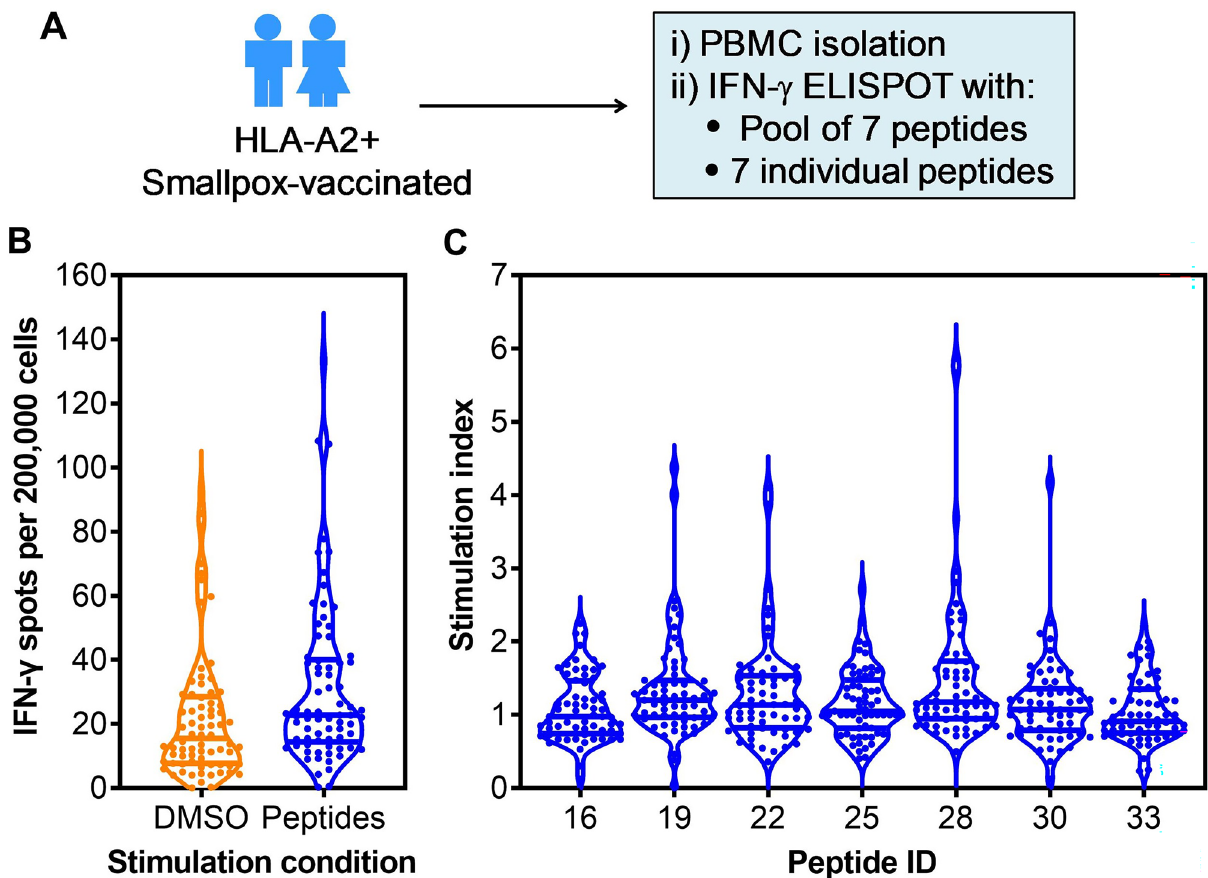
Figure 4. Immunogenicity of seven selected peptides in human PBMCs. ( A ) PBMCs were isolated from smallpox-vaccinated participants (n = 83) and used for a human IFN-γ ELISPOT assay. There were two cohorts of participant (n1 = 83, n2 = 64) recruited for the isolation of PBMCs used in IFN-γ ELISPOT assay with a pool of seven peptides ( B ) and seven individual peptides ( C ), respectively. DMSO was used as negative control. The experiment was replicated two times with PBMCs from each